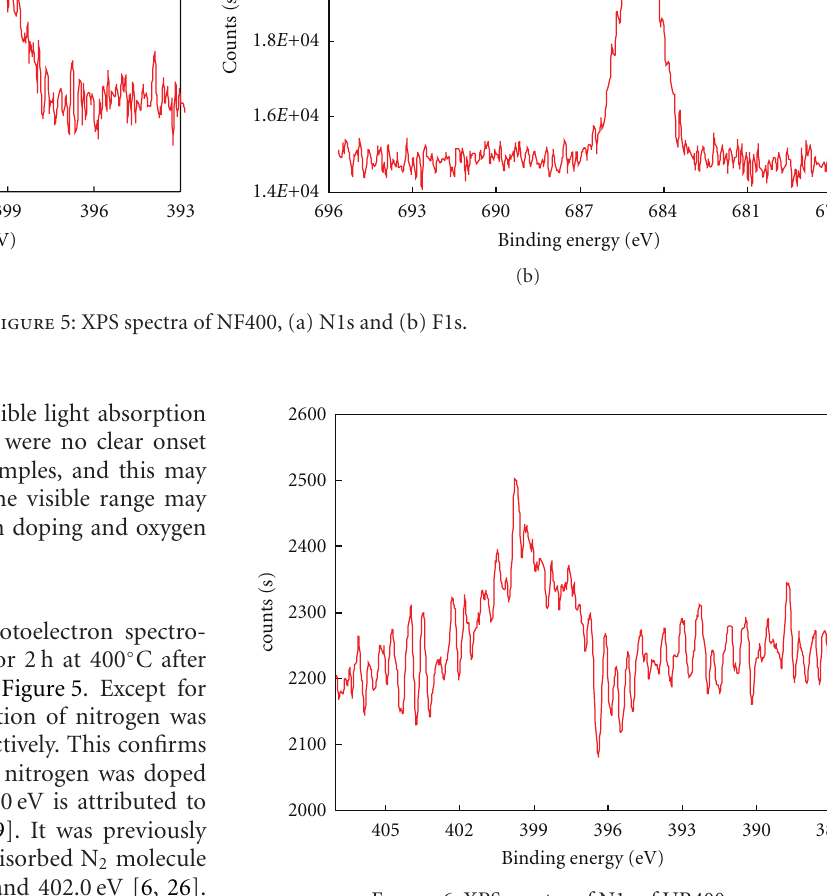
Figure 6: XPS spectra of N1s of